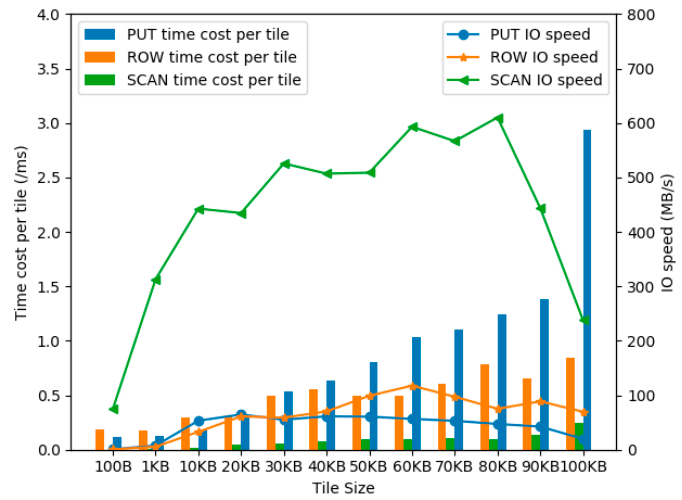
Figure 9. Time cost per tile and I/O speed with tiles of different sizes for PUT, ROW, and SCAN.